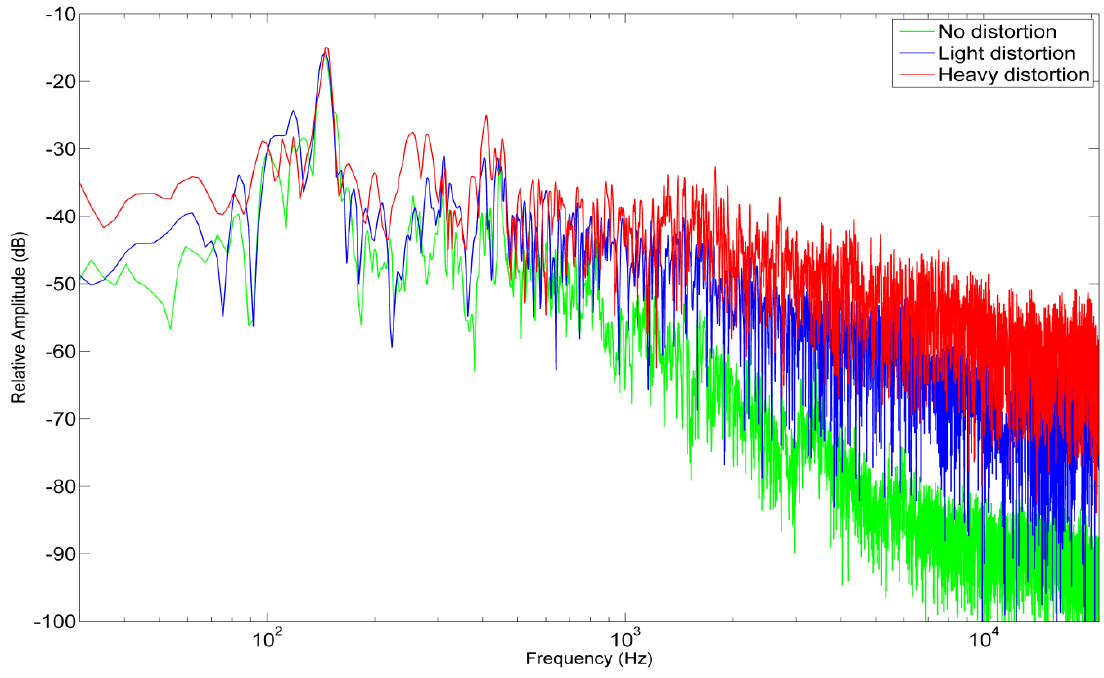
Figure 8. Three signals with different levels of distortion. The x -axis represents the frequency (Hz) and the y -axis represents relative amplitude